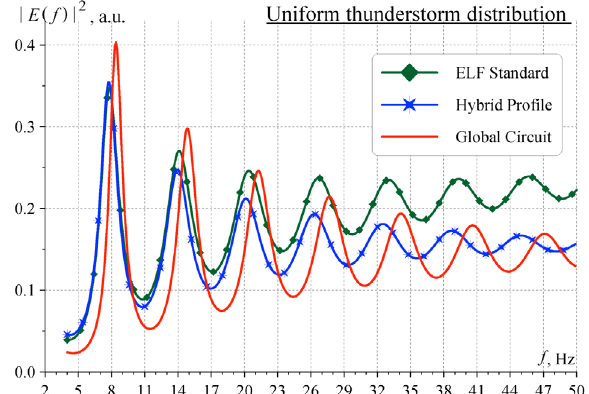
Figure 4. Power spectra of vertical electric field in arbitrary units (see text for a full